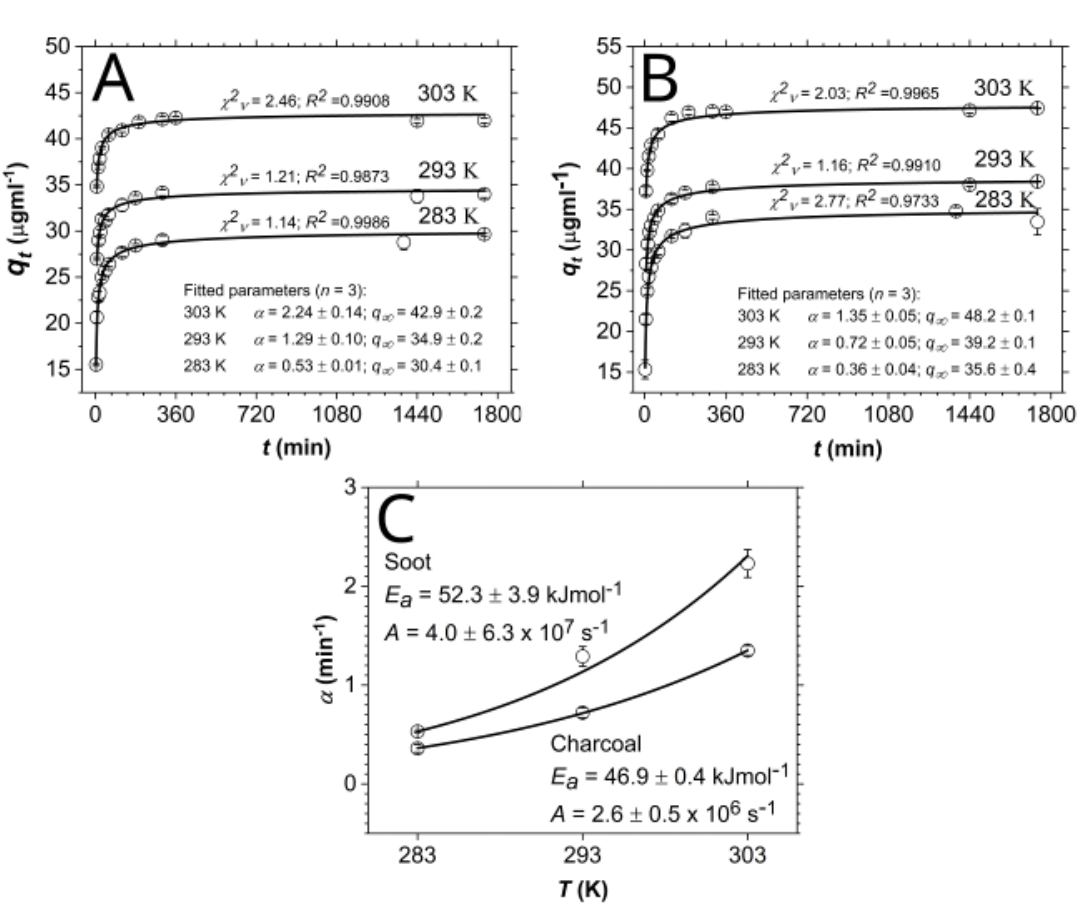
Figure 3 . Kinetic experimental data (empty circle) with the Ritchie kinetic model (full line), corresponding quality of fits ( χ 2 ν , R 2 ) and fitted parameters for A) soot and B) charcoal. q ∞ expressed in μgml -1 and α in min - 1 . Adsorption conducted in 100 mM NaCl and pH = 7. C) Arrhenius plot derived from the kinetic rates (empty circle) showing a logarithmic fit to the data (full line) with the calculated adsorption activation energy ( E a ) and the kinetic pre-factor ( A ). All uncertainties given as standard